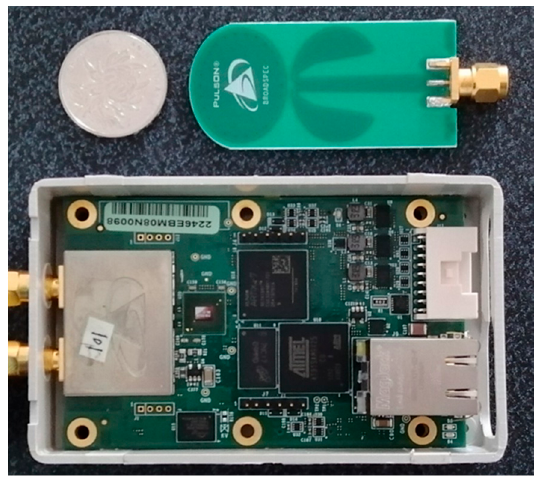
Figure 3. The BroadSpec planar elliptical dipole antenna (top) and Pulson P440 IR-UWB radar (bottom) that we used in our experiments.